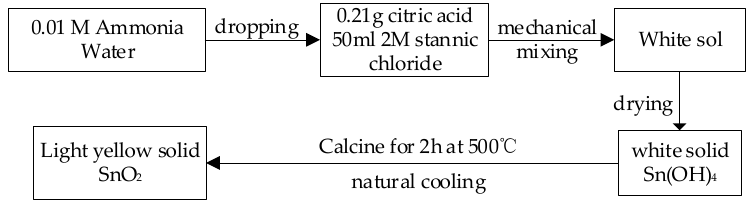
Figure 2. Preparation process of SnO 2 .